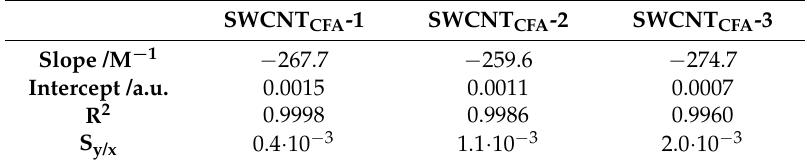
Table 1. Figures of merit of the three linear absorptometric calibration plots obtained by the ordinary least square regression model from data obtained using three different SWCNT CFA